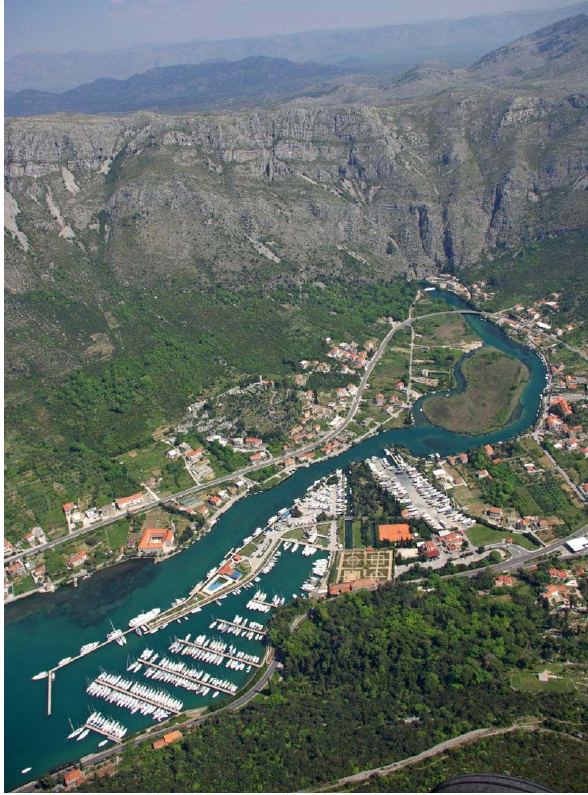
Figure 2 Fig. 2. Areal photograph of the Ombla Spring and surrounding area (taken by Antun